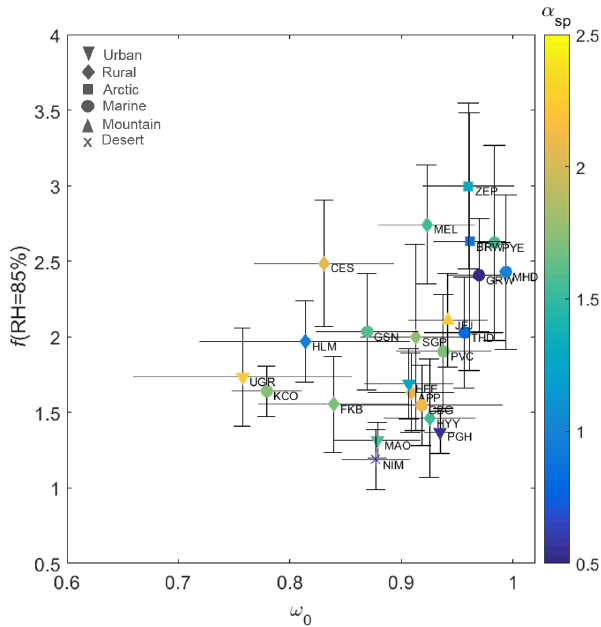
Figure 7. Scatterplot of mean f (RH = 85%) versus single- scattering albedo, ω 0 , at 550nm ( λ = 525nm at HYY) color-coded by the scattering Ångström exponent, α sp , for the wavelength pair 450–700nm at each site. The dots represent the mean value, and the error bars are the standard